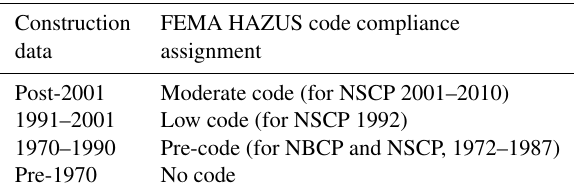
Table 2. HAZUS building seismic-design-level